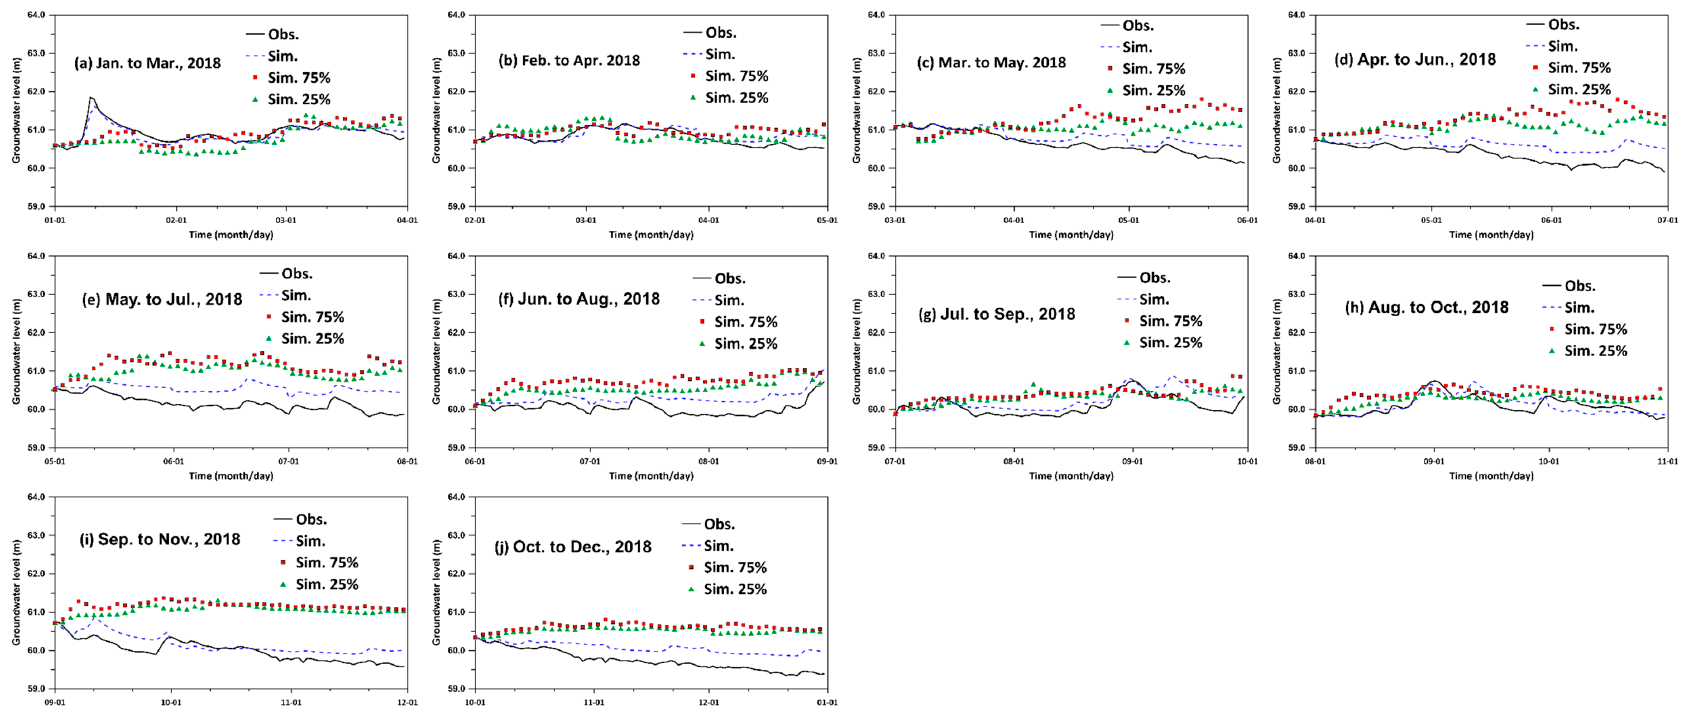
Figure 7. All 3 month groundwater outlooks from January to March 2018 through October to December 2018: ( a ) January to March; ( b ) February to April; ( c ) March to May; ( d ) April to June; ( e ) May to July; ( f ) June to August; ( g ) July to September; ( h ) August to October; ( i ) September to November; ( j ) October to December. Note that the horizontal axis indicates the simulation time, and the vertical axis represents the groundwater levels. The black lines represent the observations; the blue dashed lines denote the simulation results using real rainfall data; the green triangles and red squares indicate the simulation results using forecast rainfall at the 25th and 75th percentiles, respectively.